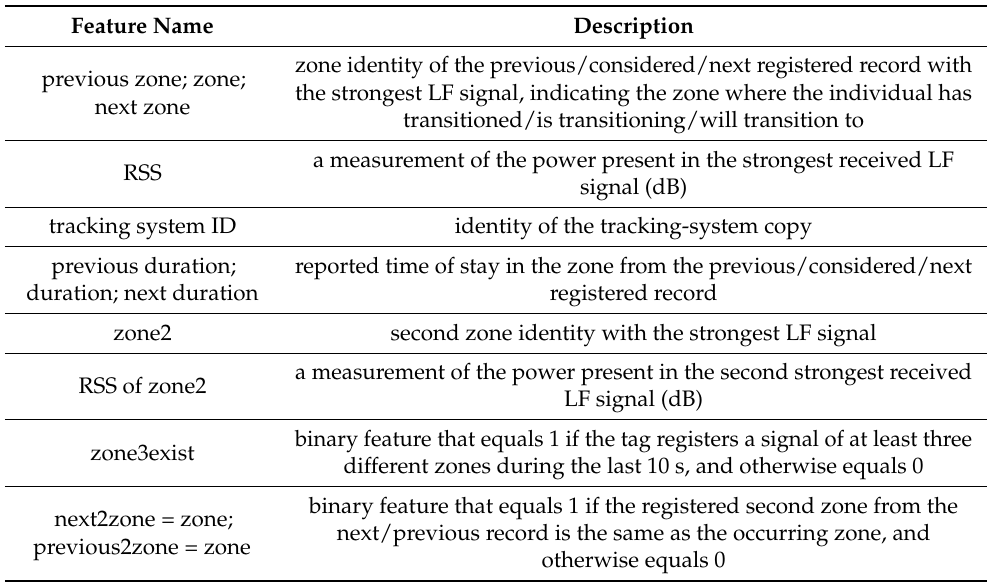
Table 1. Record features used to train the model and the normalized importance of features in the final CatBoost